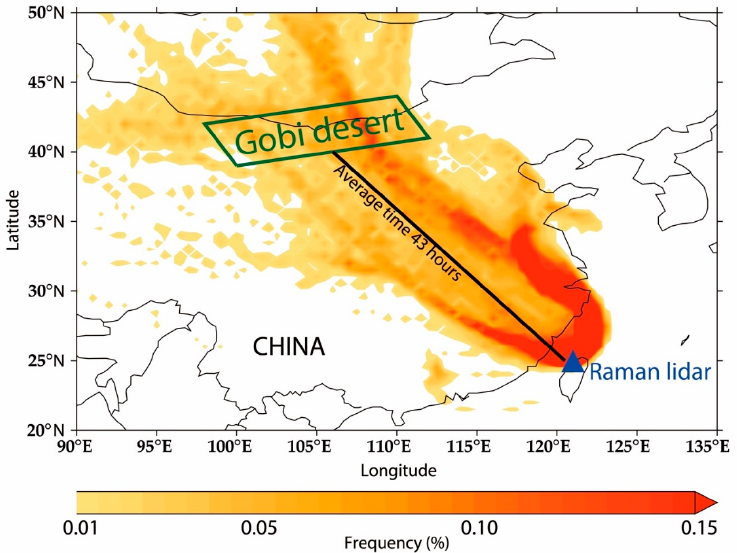
Figure 3. Probability density function (PDF) calculated for approximately 500 single backward trajectories obtained from the HYSPLIT model for the altitude range from 100 to 3500 m during the period of 12:00 to 24:00 LST on 14 March 2009. The time interval and the altitude resolution are 1 h and 100 m, respectively. The resolution of each latitude/longitude grid is 0.5° × 0.5°. The vertical structures of dust aerosols were measured by the spaceborne CALIPSO lidar, as shown in Figure 4. At 13:09 LST on 14 March 2009, CALIPSO passed over most of China while on a northward orbit. The CALIPSO measurements are useful for understanding the origin and the transport of the dust storm. One can see that a dust aerosol layer from the surface to 2 km height covered most of the area below the CALIPSO orbit in the eastern China at latitudes of 25°N to 40°N, from the western Taiwan Strait to Inner Mongolia at a length of approximately 2200 km. The mean profiles of total attenuated backscatter at 532 nm, DR, and color ratio are calculated from CALIPSO lidar observation around 13:40 14 March over east China (32°N–38°N, 112°E–116°E), as shown in the right panel of Figure 4. Error bars are standard deviations computed from the vertical bins of each profile. CALIPSO measurements show a DR of about 0.2 and a color ratio of about 0.6. In addition, an optically thinner dust layer with DR of about 0.1 located between 3 km and 5 km was also observed.